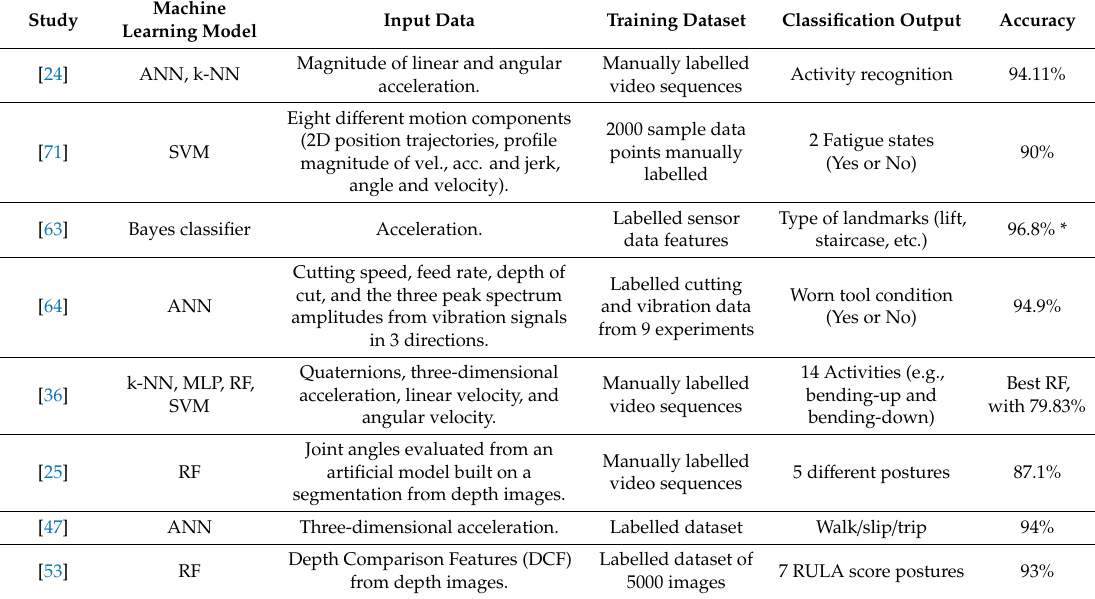
Table 7. Machine learning classification